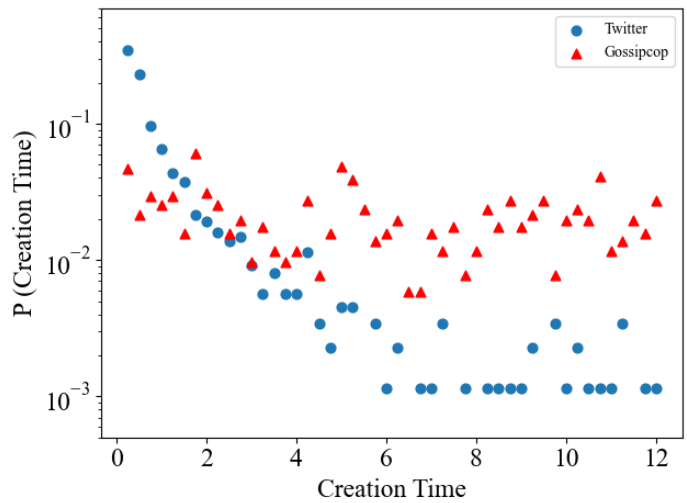
Figure 4. The distribution of creation time in two